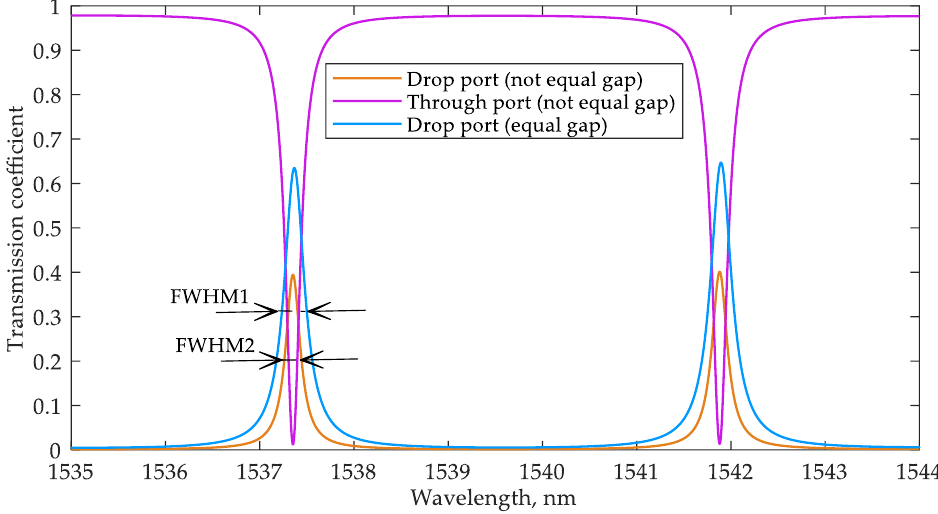
Figure 5. Transmission spectra of the through and drop ports of the sensor MRR.